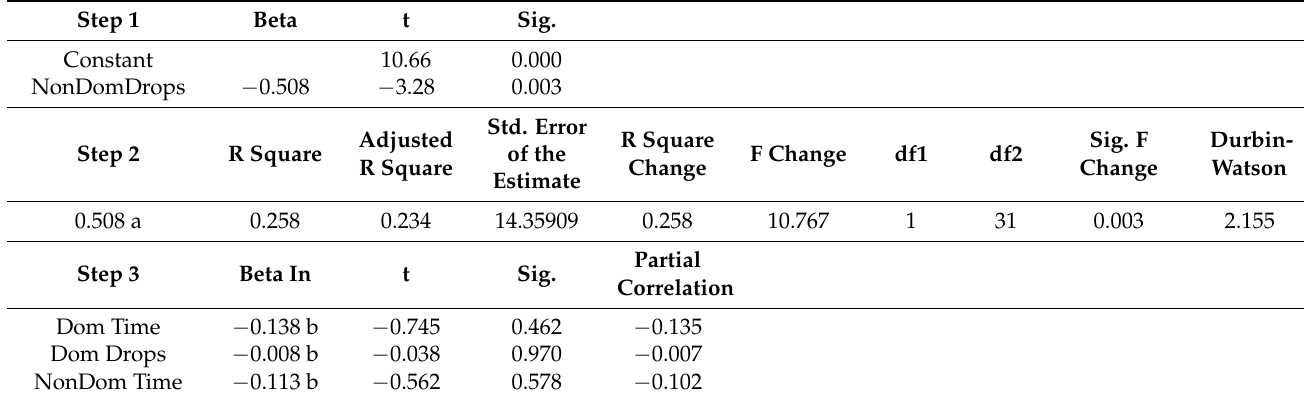
Table 7. Linear Regression for Math Stories and Grooved Pegboard variables.